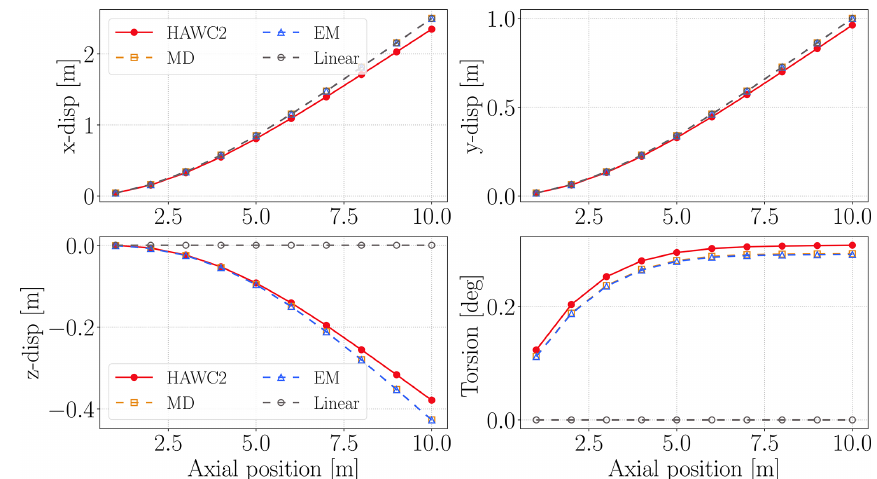
Figure 9. Straight-beam x , y and z displacements and torsion motion results along the beam span. The static load has x and y components.